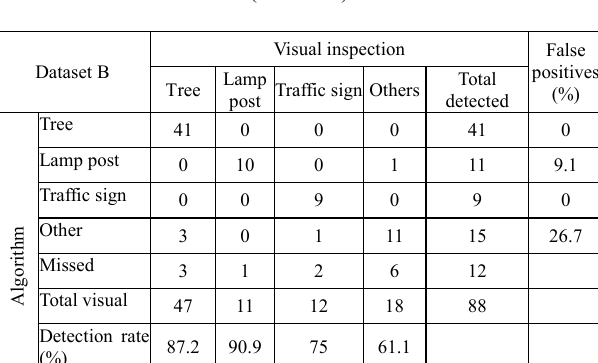
Table 2: Performance with & without PCI based on object wise (dataset A)